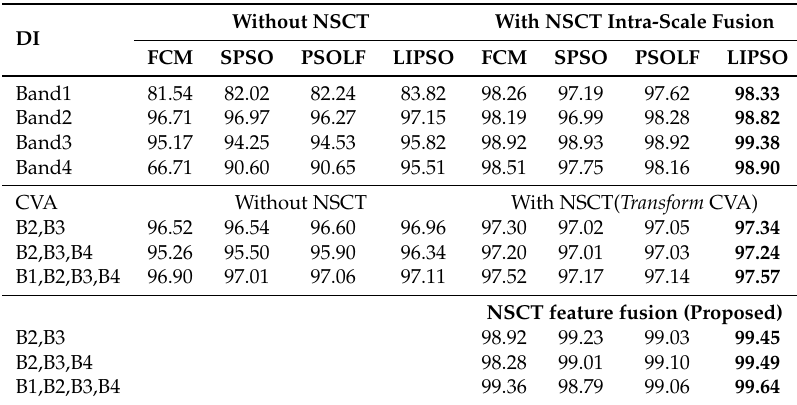
Table 1. Overall Accuracy (OA) obtained for Fuzzy C means (FCM) [3], Standard Particle Swarm Optimization (SPSO) [47], PSO with Lévy flight (PSOLF) [43], Leader Intelligence PSO (LIPSO) (proposed) on Itezhi, Tezhi Reservoir, Zambia data set.